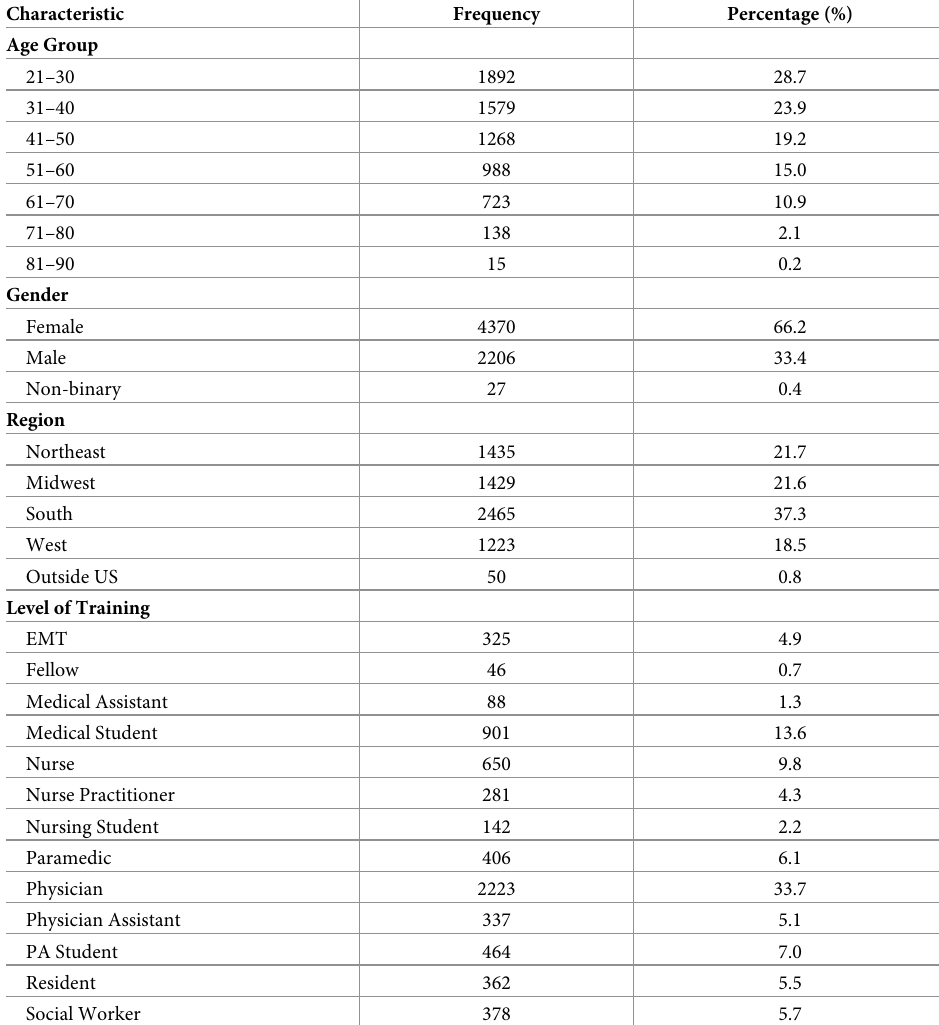
Table 2. Demographic